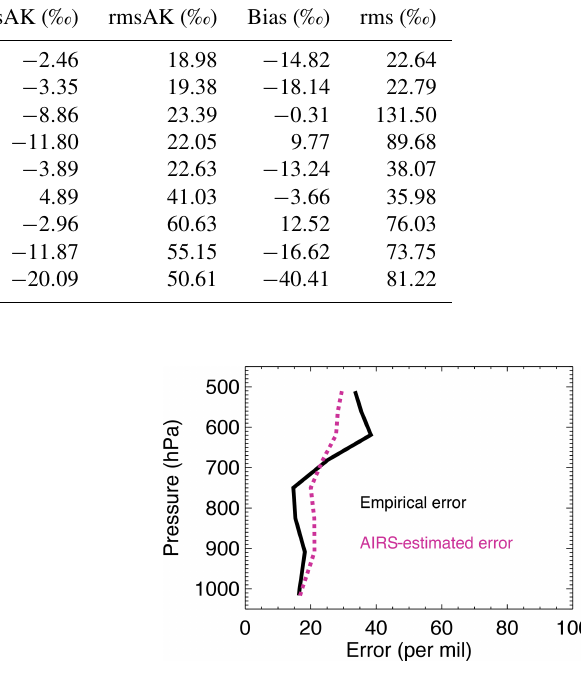
Figure 5. Plot of AIRS error analysis for coincident AIRS and OR- ACLES δ D on 31 August 2016, which shows that the empirical er- ror is comparable to the AIRS-estimated error. The empirical error is obtained from the statistics of the satellite–aircraft comparison, while the estimated error is obtained from optimal estimation re- trieval theory. Plotted here are the AIRS δ D-estimated error, also known as AIRS observation error (dashed red line), and the AIRS δ D empirical error (black